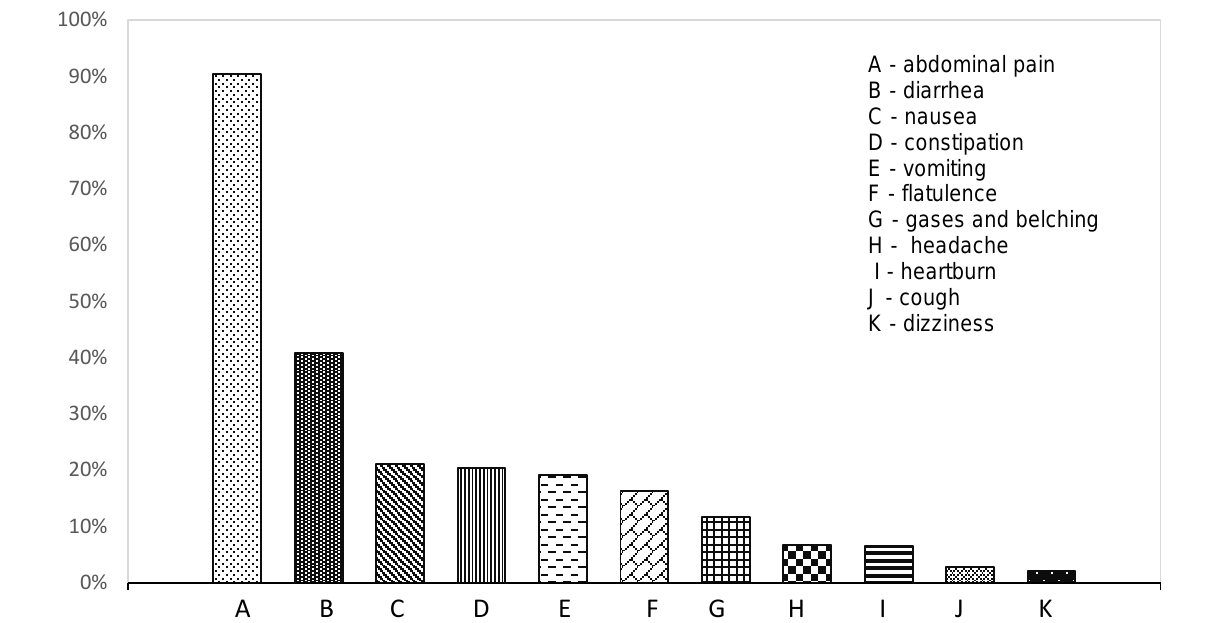
Figure 1. The frequency of reported symptoms in all diagnosed patients. After assignment into two subgroups depending on the HBT results, we found an almost identical distribution of reported symptoms, with no significant differences be- tween children with positive and negative fructose HBT. The most common symptoms in the group with positive HBT results were abdominal pain (89.47%); then diarrhoea (40.35%); then nausea, vomiting, and bloating (20.18%). The frequency of reported symp- toms depending on the result of the fructose HBT test is presented in Table 2. Table 2. The frequency of reported symptoms depending on the result of the fructose HBT test.